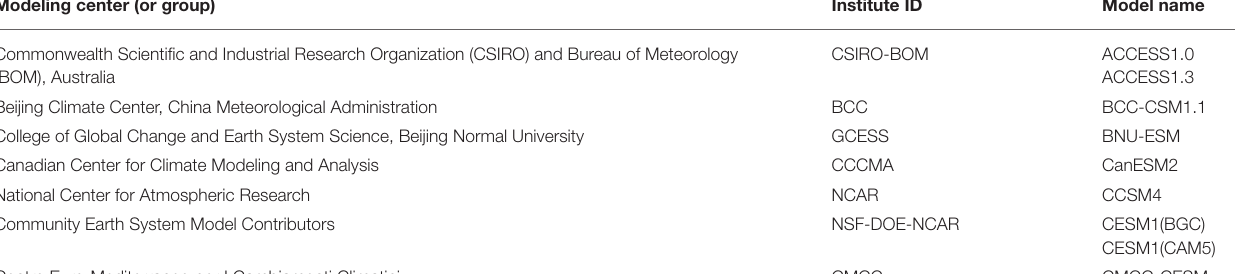
TABLE 3 | Climate model simulations used in the study. Modeling center (or